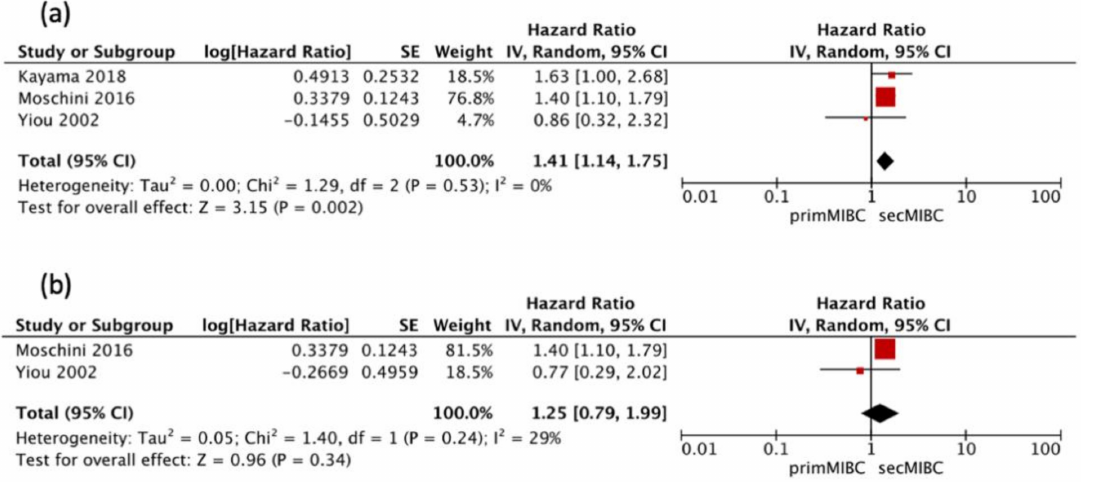
Figure 6. ( a ) Forest Plot PFS 5-year after RC, ( b ) Forest Plot PFS 10-year after RC. Two of these studies [7,16] were available for HR calculation of 10-year PFS between primMIBC and secMIBC. Pooled analysis showed no significant differences in 10-year PFS (pooled HR 1.25, 95% CI 0.79–1.99, p = 0.34), without significant heterogeneity between studies (Chi 2 = 1.40, I 2 = 29%, p = 0.24) (Figure